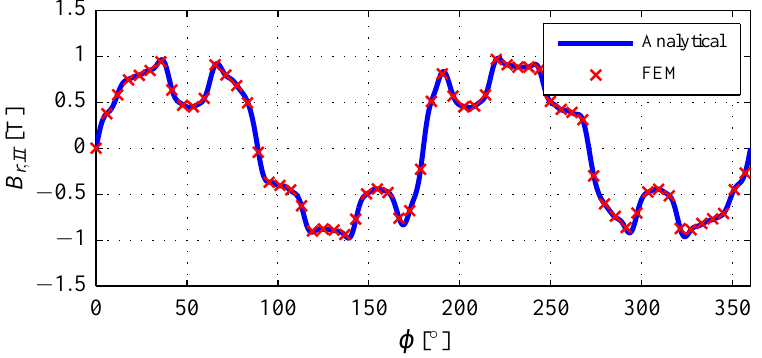
Figure 9. Airgap radial magnetic flux density (region II) of the magnetic